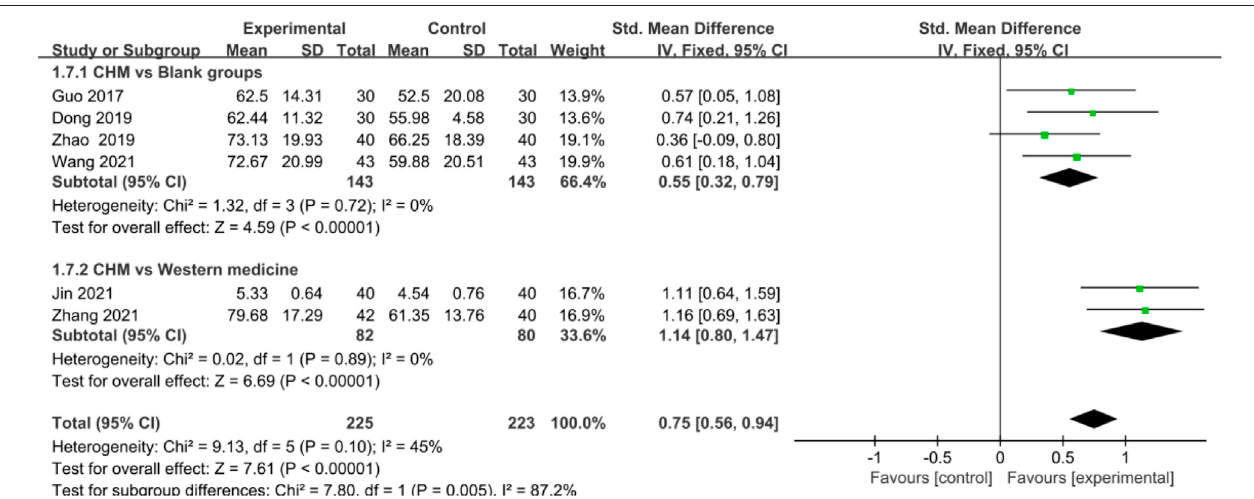
FIGURE 4 | Forest plot: CHM for improved AS of CHD with anxiety compared with control groups.